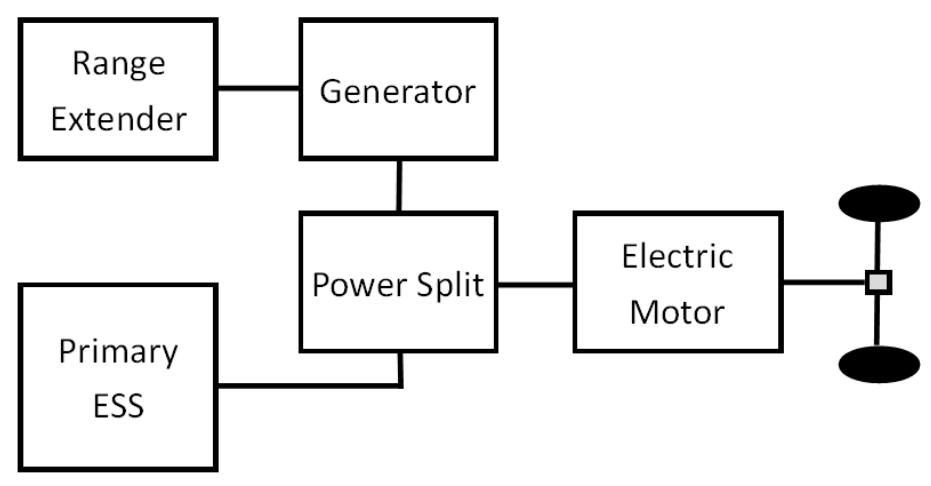
Figure 1. Schematic of a simple series hybrid powertrain with a range extender.